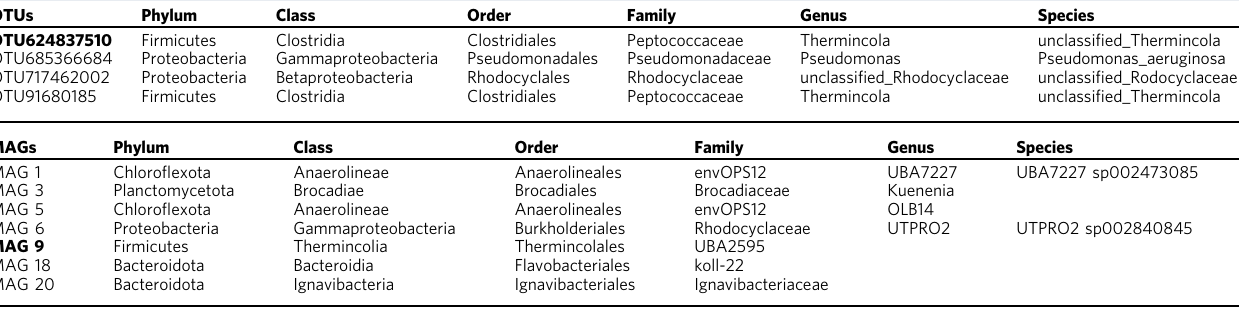
Upper table) Taxonomy assignment of strongly correlated OTUs. The selection was based on random forest variable importance and PERMANOVA analysis. Bottom table) The dominant MAGs in the microbial community of the bioreactor. Note that OTU624837510 from the succession experiment and MAG 9 from the bioreactor are marked in bold font as their 16S rRNA sequences are